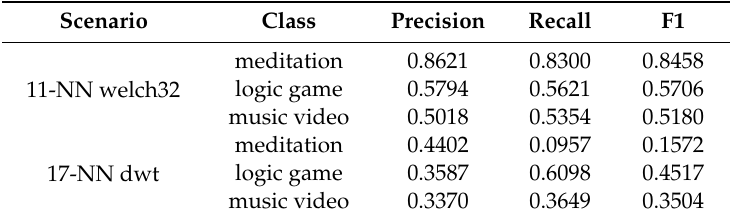
Table 7. Values of precision, recall, and F1 score in 10-fold cross-validation for the best and the worst feature extraction method variants of Experiment 1 ( k -NN